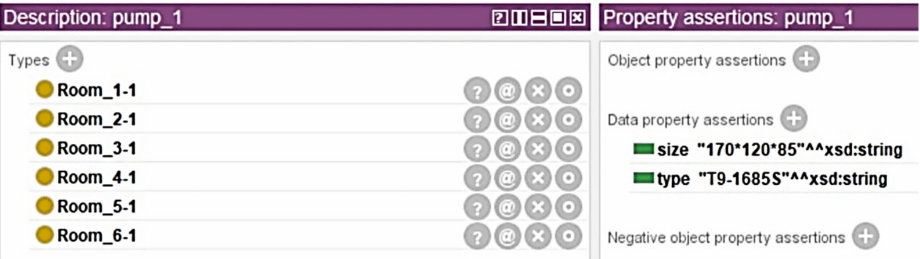
Figure 10. Example of the individuals in the ontology framework.